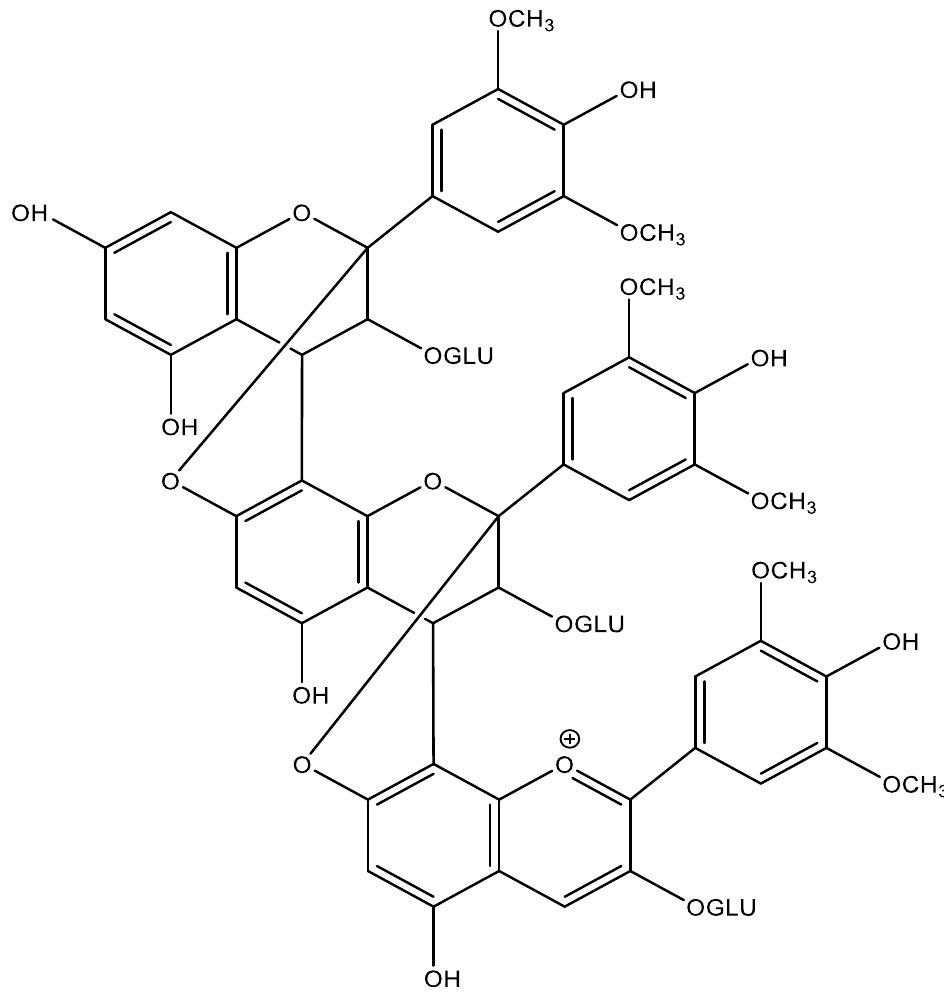
Figure 7. Trimeric anthocyanin